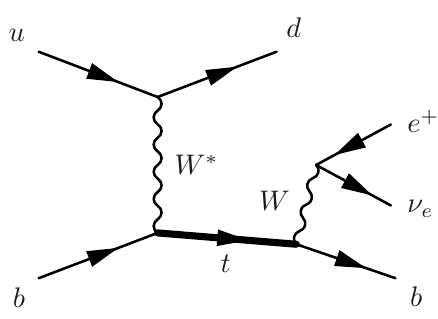
Figure 1 . The LO Feynman diagram for single top-quark production and decay at hadron colliders. Top quark is represented by a thick line. We show only one partonic channel in this (cid:12)gure.